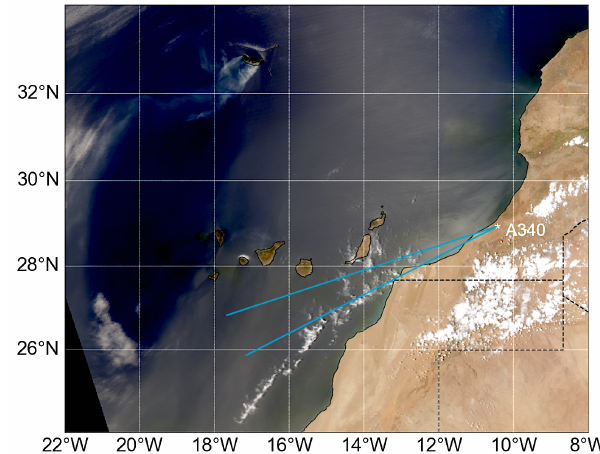
Figure 5. MODIS/Aqua true-colour image showing a dust outbreak off the coast of Western Sahara on 19 July 2012 at 13:55 UT. The location of the A340 is shown and the approximate viewing direction of the IR cameras is indicated by the blue-coloured